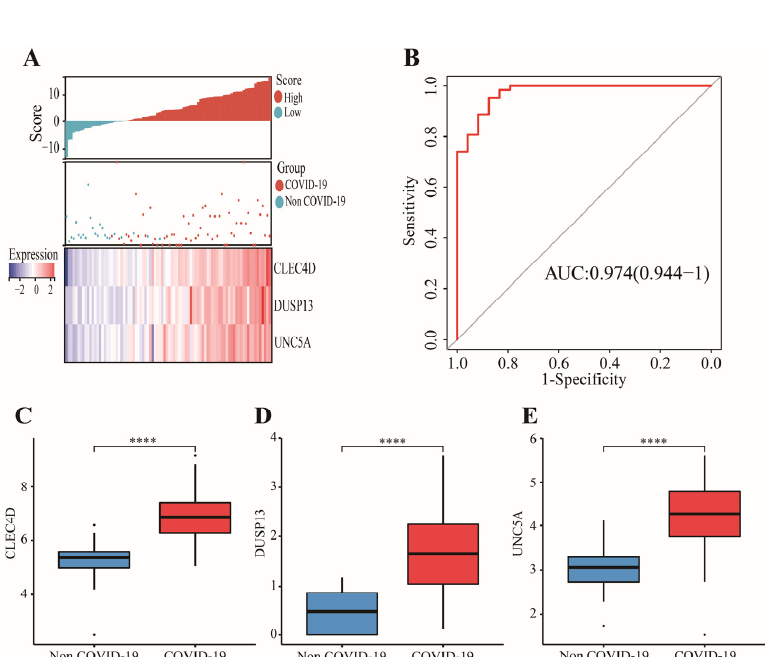
Figure 7. Identification of a 3-gene signature in GSE152641. ( A ) Different outcomes and expressions of CLEC4D, DUSP13, and UNC5A between high- and low-score groups. ( B ) The AUC for prediction of outcome. ( C – E )The expressions of CLEC4D, DUSP13, and UNC5A between COVID-19 and non-COVID-19 groups. Data in ( C – E ) were analyzed by Wilcoxon test; ns, no significance; **** p < 0.0001.